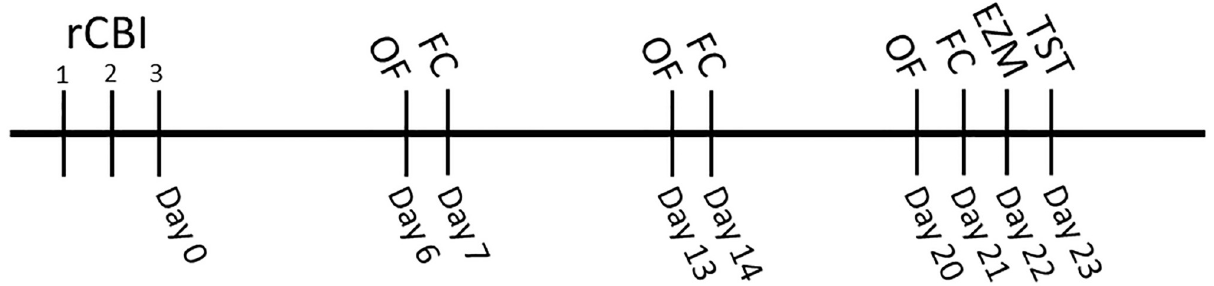
Fig 1. Experimental timeline. Concussive brain injuries, repeat (rCBI), were performed on three consecutive days, with mice sustaining one injury each day. Mice were tested in the open field (OF) arena on days 6, 13 and 20 following the final CBI. Fear conditioning (FC) association (footshock/auditory stimulus pairings) took place one week following rCBI, with context and cue testing one and two weeks later. Testing for anxiety- and depressive-like behaviors were performed in the elevated zero maze (EZM) and tail suspension test (TST), respectively, on days 22 and 23 following